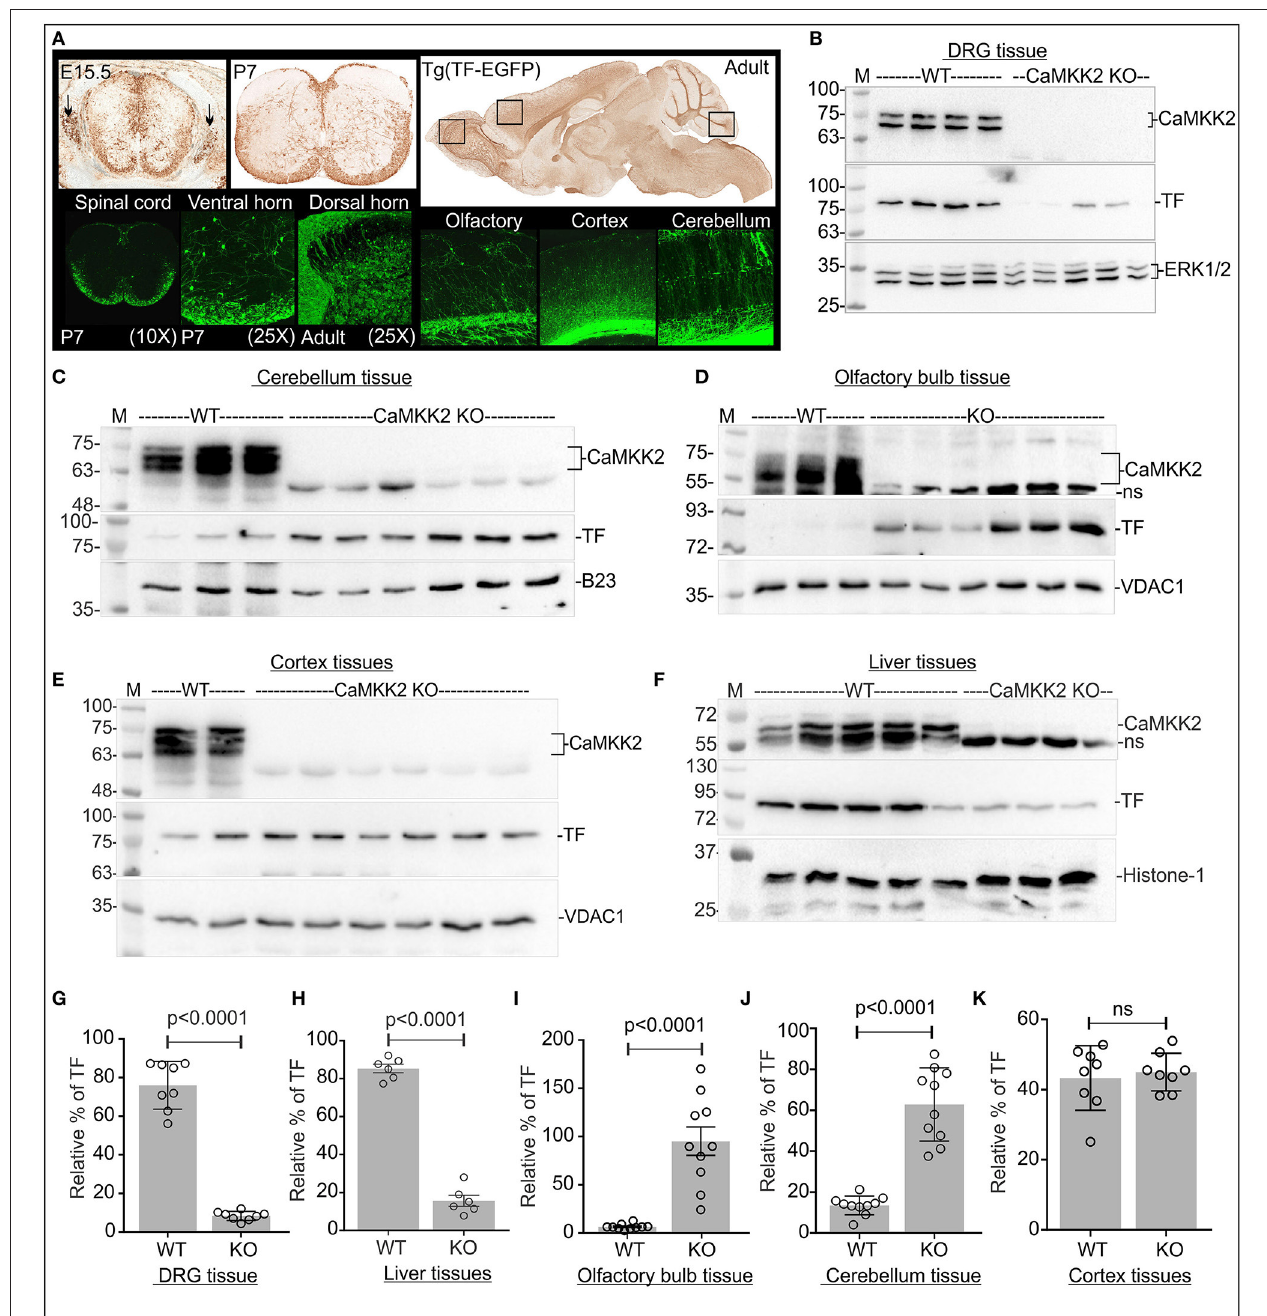
FIGURE 5 | Loss of CaMKK2 differentially affected relative abundance of total TF in a tissue-specific manner in the CaMKK2 KO mouse. (A) TF promoter-trapped GFP reporter expression in adult, postnatal (P7) and embryonic 15.5 stage spinal cord, DRGs and adult brain tissues (founder line: IF181). The images were obtained from The Gene Expression Nervous System Atlas (GENSAT) Project, NINDS Contracts N01NS02331 & HHSN271200723701C to The Rockefeller University (New York, NY). Top panel: GFP-immunostaining of paraffin-embedded sections. Bottom panel: GFP epifluorescence in cryomicrotome sections. (B–F) Immunoblots showing expression of CaMKK2, TF, and ERK1/2, VDAC1, histone-1 (H1), nucleophosmin (B-23), and GAPDH in different adult mouse tissues. (G–K) Scatter plot showing the relative amount of TF in different adult mouse tissues. DRG tissue: ERK1/2 used for normalization, N = 8 replicates from 4 mice in each category. Olfactory/cerebellum tissues: GAPDH/B23 used, respectively, for normalization. N = 10/5 replicates from 3 KO and wild-type mice, respectively. Cortex/Liver tissues: VDAC1/H1 used, respectively, for normalization, N = 8/6 replicates from 3 CaMKK2 KO and wild-type mice, respectively. The p -value by t -test (unpaired).